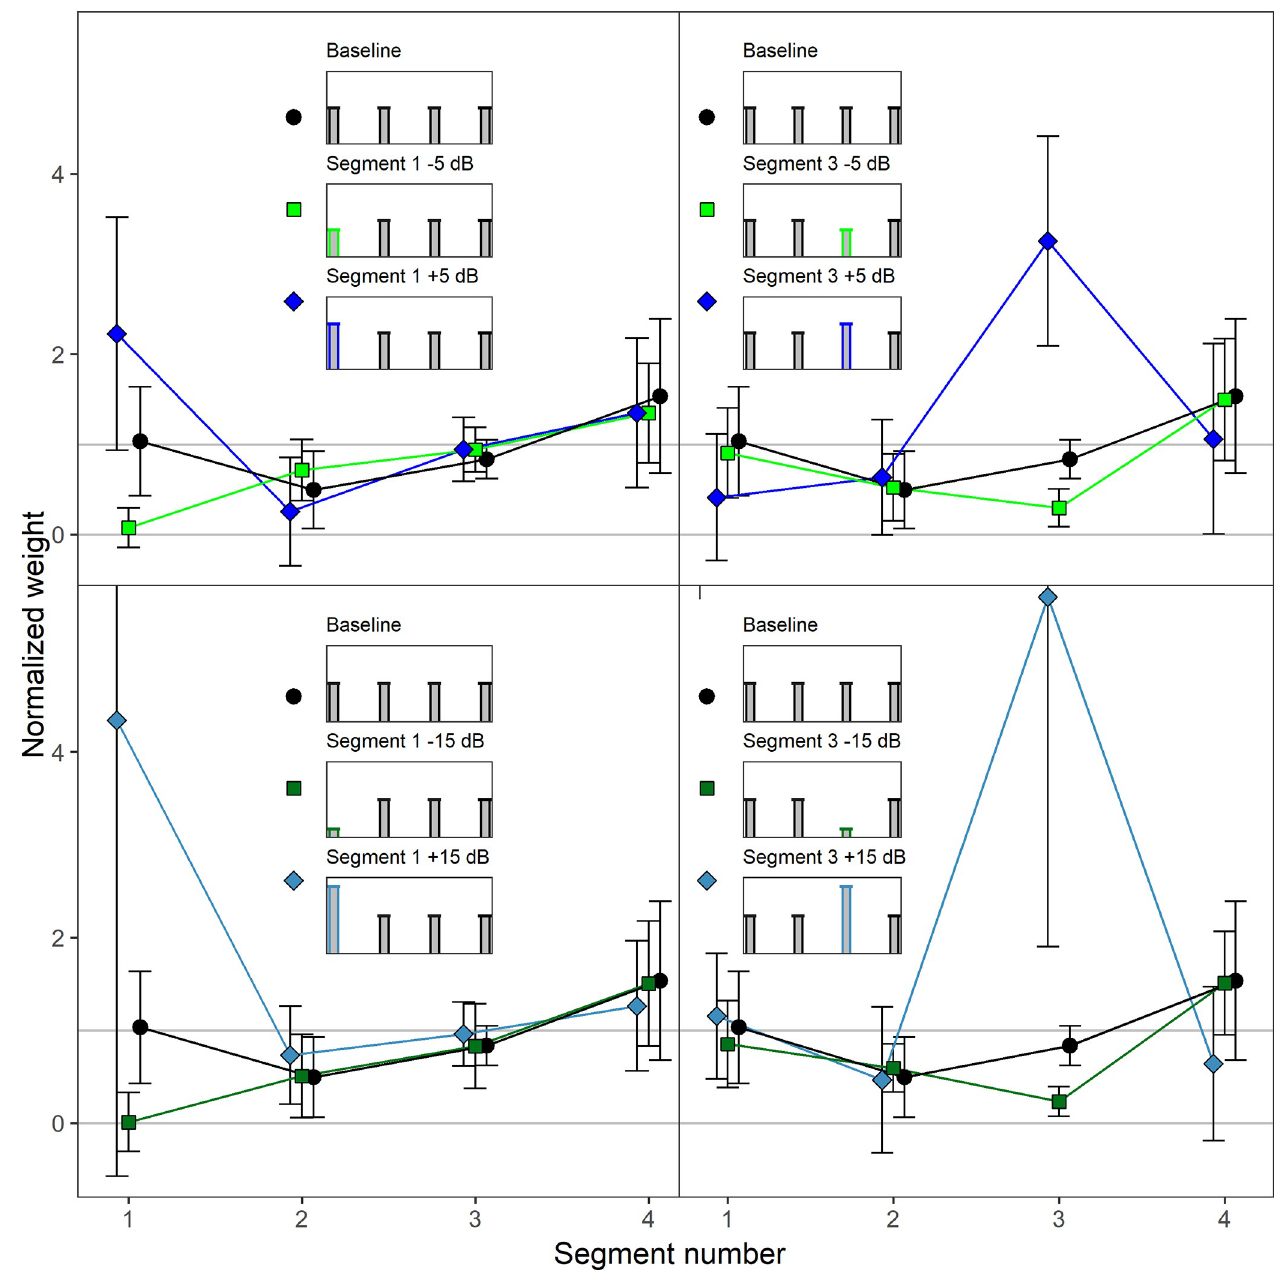
Fig 2. Experiment 1. Mean normalized weights as a function of segment number. In each panel, depictions of the mean level profiles of the corresponding stimuli are shown in the upper half. The weights observed in the baseline condition containing no amplified or attenuated segments are plotted in all panels of the figure for reference. Black circles: Baseline condition (mean level identical for all of the four segments). Light green squares: Attenuation by 5 dB. Dark green squares: Attenuation by 15 dB. Blue diamonds: Amplification by 5 dB. Blue-gray diamonds: Amplification by 15 dB. Error bars show 95% confidence intervals (CIs) of the mean. Note that for better visibility, the lines are shifted slightly against each other on the x-axis. segments increased, relative to the weights of the same segments in the baseline condition. In contrast, if the level of one of the segments was attenuated ( − 5 or − 15 dB; light and dark green squares), the relative weights on that particular segment decreased. This was the expected pat- tern, compatible with loudness dominance. The pattern of weights on the segments with